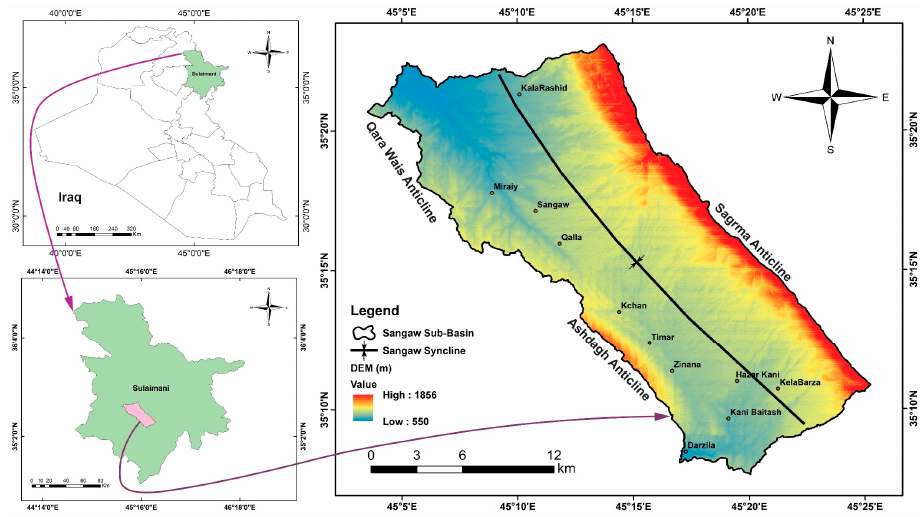
Figure 1. Location map of the study area.